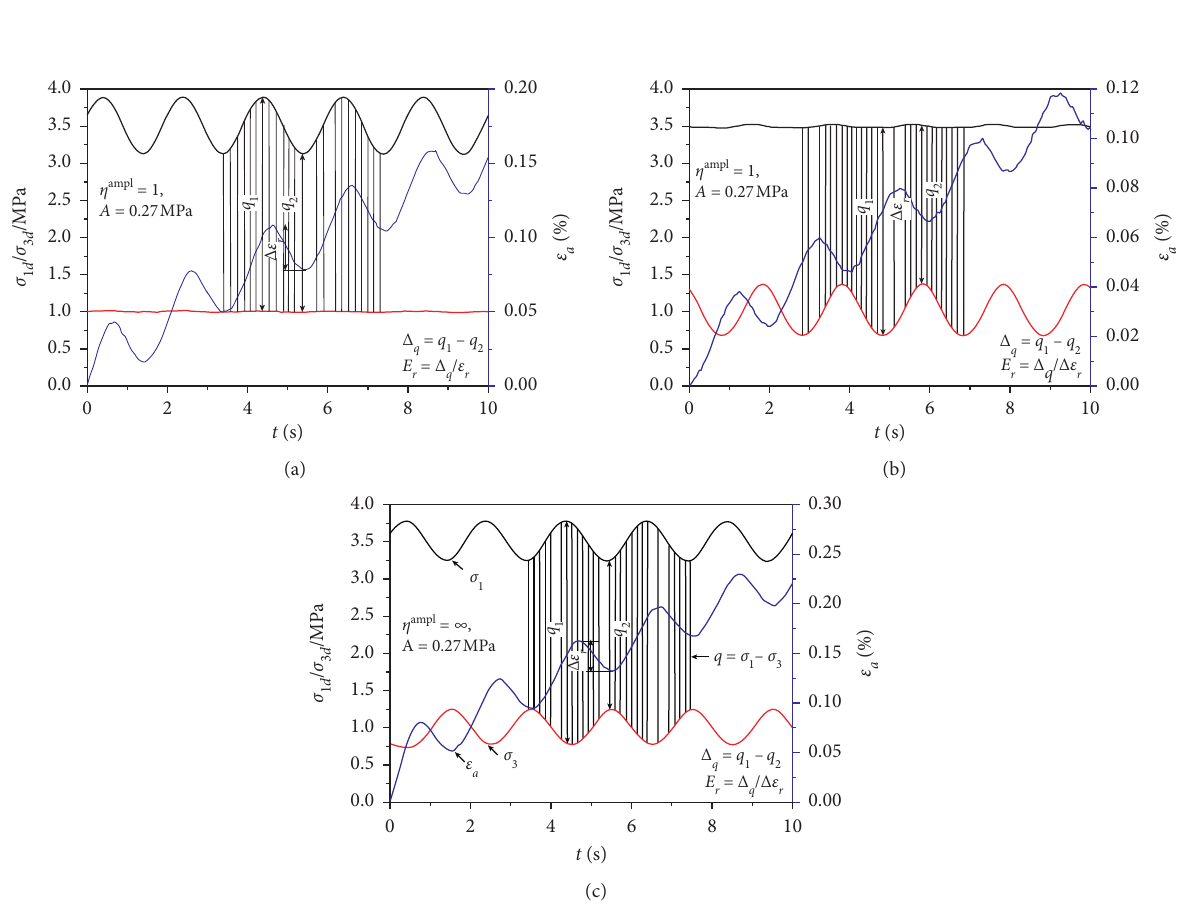
Figure 4: The resilience modulus calculation methods under different dynamic stress paths.